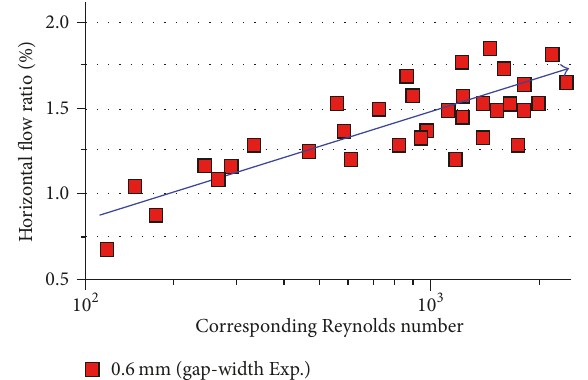
Figure 7: Horizontal flow ratio versus Reynolds number at 0.6 mm.